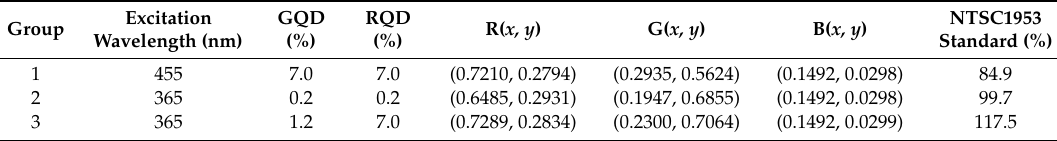
Figure S1: Transmission spectrum of (a) GQD and (b) RQD film; Figure S2: PL shift phenomenon of (a) GQD film and (c) RQD film; Figure S3: (a,d) GQD absorption rate; (b,e) GQD conversion e ffi ciency; (c,f) output radiant flux and energy conversion e ffi ciency under 60- and 100-mW incident radiant flux; Figure S4: Electroluminescence (EL) spectrum of RQD LED with (a) 365 nm, (b) 385 nm, (c) 405 nm, and (d) 455-nm LED chip excitation